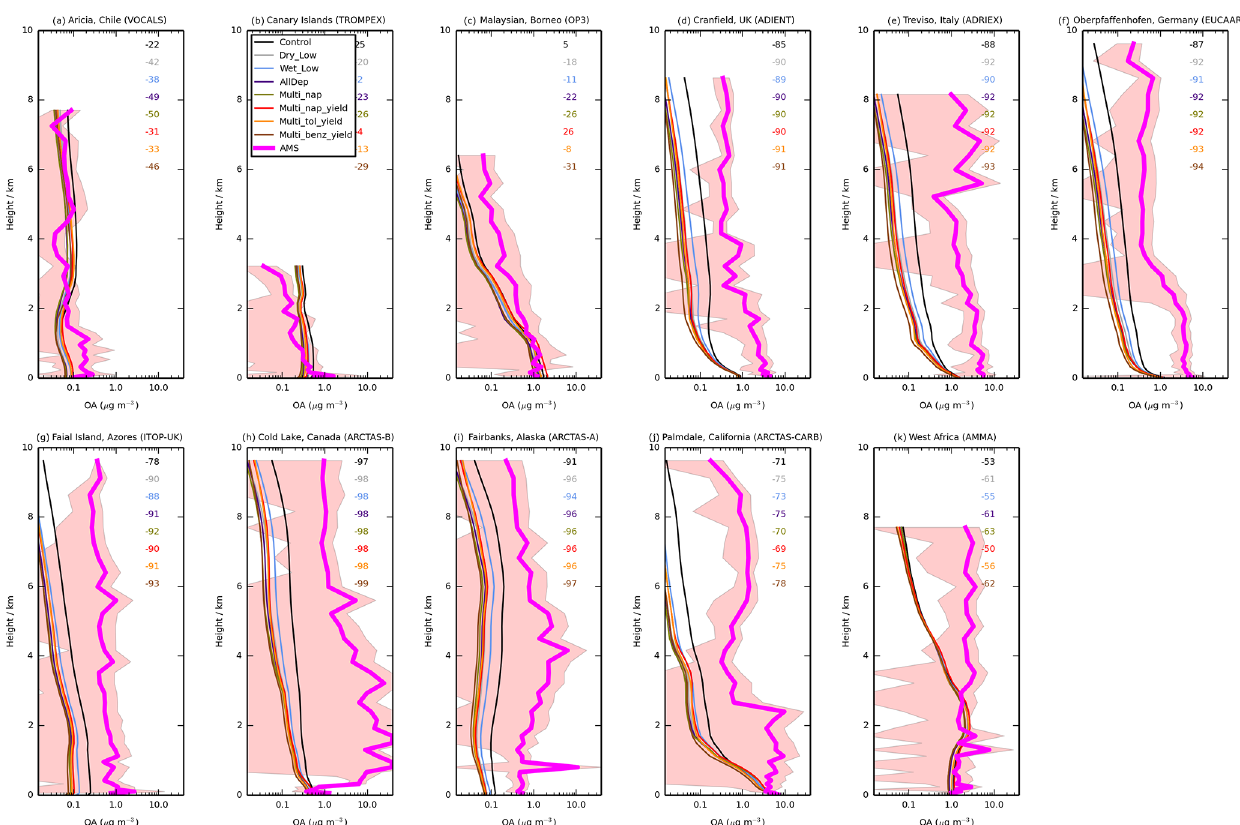
Figure 6. Mean vertical profile of OA (µgm − 3 ) from 11 field campaigns (pink) with monthly mean modelled OA from UKCA for the simulations described in Table 3. The standard deviation of the binned observations at each model layer is shown (peach envelope). For each campaign, the normalised mean bias (%) for each simulation is also included in the top right of each